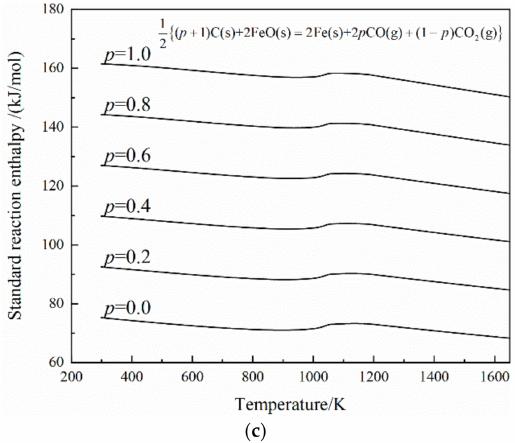
Figure 15. The standard reaction enthalpy as a function of temperature: ( a ) the reaction of ( m + 3)C(s) + 2Fe 2 O 3 (s) = 4Fe(s) + 2 m CO(g) + (3 − m )CO 2 (g) ( m = 0.0, 0.5, 1.0, 1.5, 2.0, 2.5, 3.0); ( b ) the reaction of ( n + 2)C(s) + Fe 3 O 4 (s) = 3Fe(s) + 2 n CO(g) + (2 − n )CO 2 (g) ( n = 0.0, 0.5, 1.0, 1.5, 2.0); ( c ) the reaction of ( p + 1)C(s) + 2FeO(s) = 2Fe(s) + 2 p CO(g) + (1 − p )CO 2 (g) ( p = 0.0, 0.2, 0.4, 0.6, 0.8, 1.0);. Table 5. The energy consumption of heating the coupling reaction per ton iron (GJ/t). Reaction Equation Coupling